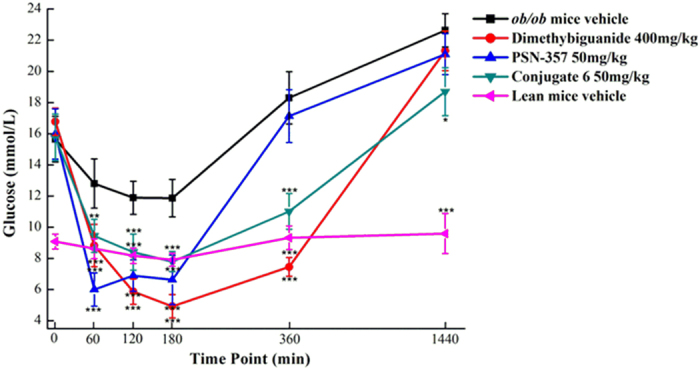
Time-course of glucose lowering following oral administration of PSN-357 and conjugate 6 in diabetic ob/ob mice.(n = 10; *p < 0.05, **p < 0.01 and ***p < 0.005 vs vehicle-treated ob/ob mice).